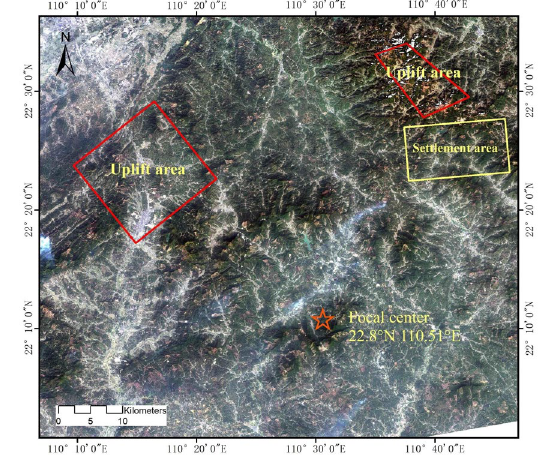
Figure 1. Overview of earthquakes in Yulin study area